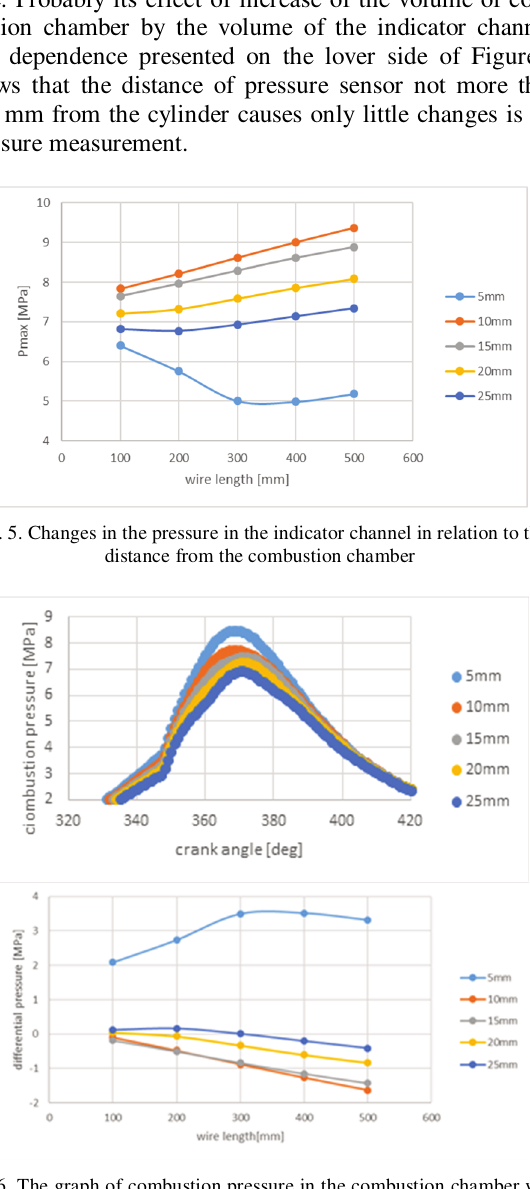
Fig. 6. The graph of combustion pressure in the combustion chamber with different diameters of the indicator channel (up) and a graph of the differ- ences between the pressure in the combustion chamber and the indicator channel